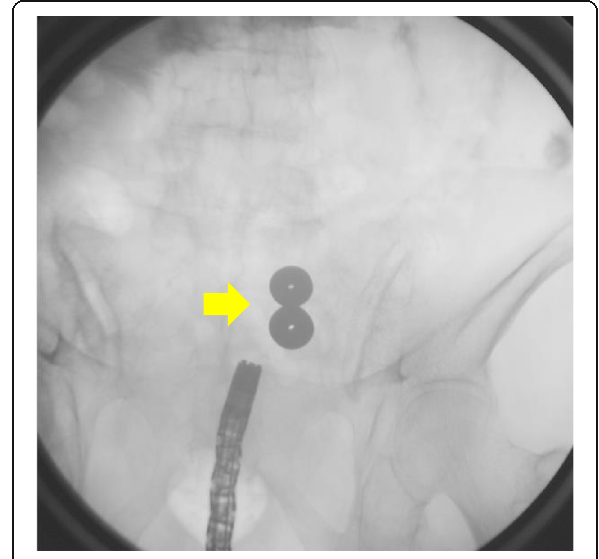
Fig. 4 Adsorption in the side-to-side direction during treatment (arrows)